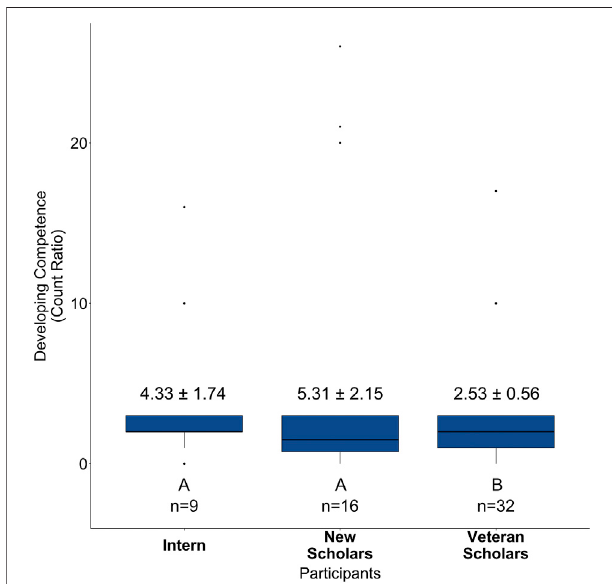
FIGURE 3 | Intern and New Scholar (Scholars who have participated in NoyceSCIENCE for < 1 year) had greater ratio counts of Developing Competence than Veteran Scholars (Scholars who have participated in NoyceSCIENCE for > 1 year). Experiences that share a letter are not signi fi cantly different. N values (count ratio of a Vector per participation level) are indicated below signi fi cant groupings and mean ± standard error is indicated above signi fi cant groupings.